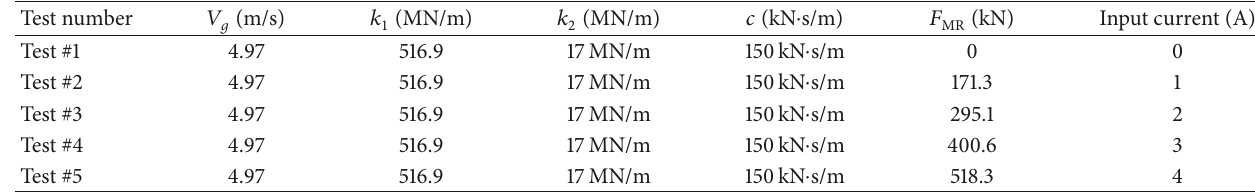
Table 2: Calculated physical coefficients for the impact testing